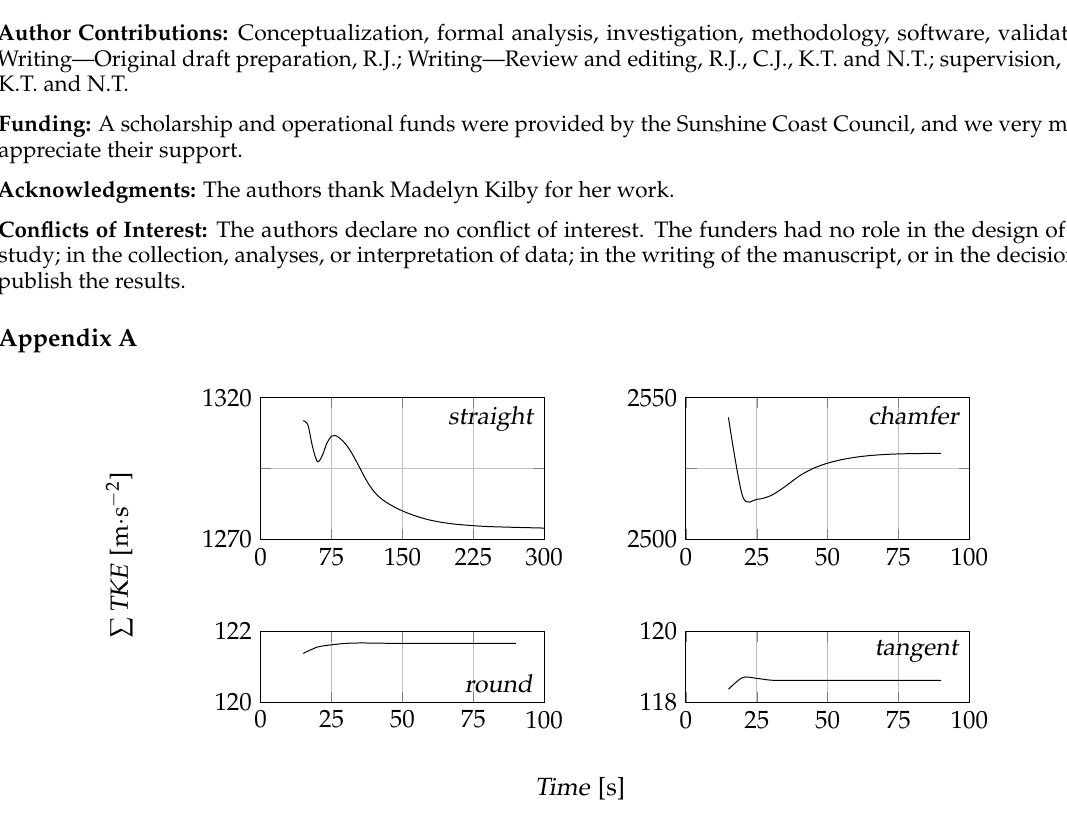
Figure A1. Convergence plot for Turbulence Kinetic Energy (TKE) in transient simulations with time step size 0.1s and 90 ◦ misalignment. These plots were used to determine the minimum time required for the transient